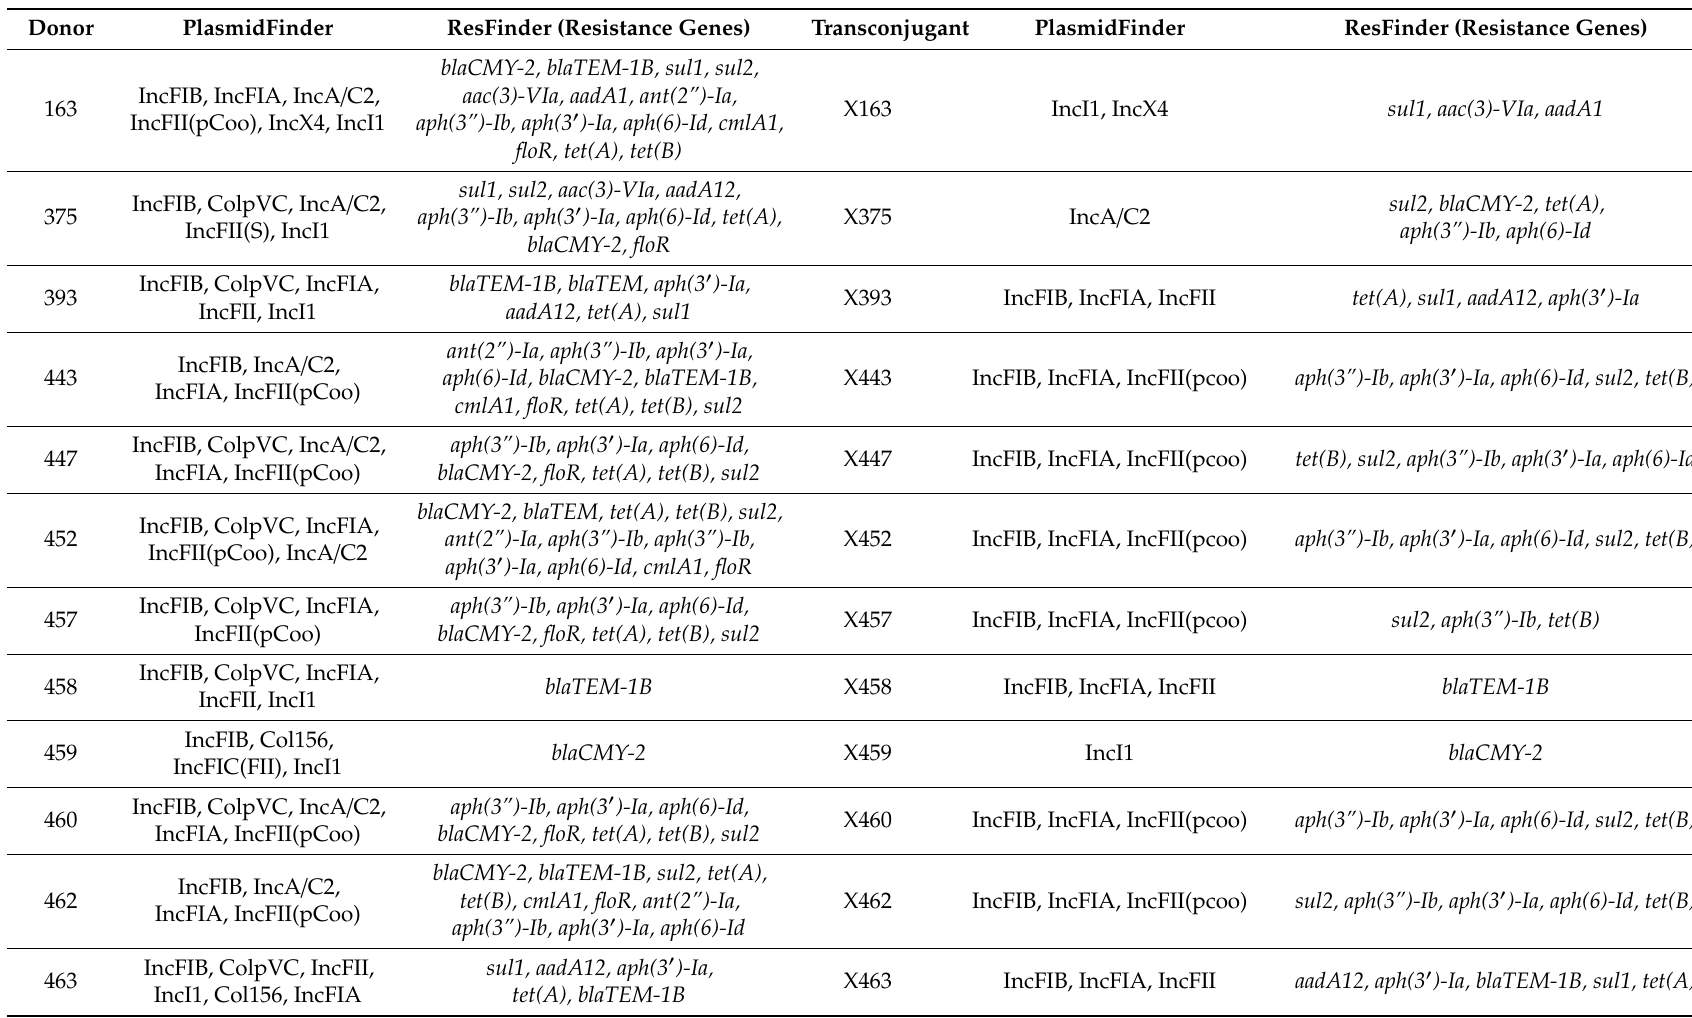
Table 3. In silico genome analysis of isolates able to transfer plasmids and antimicrobial resistance genes to recipients and able to generate transconjugants.